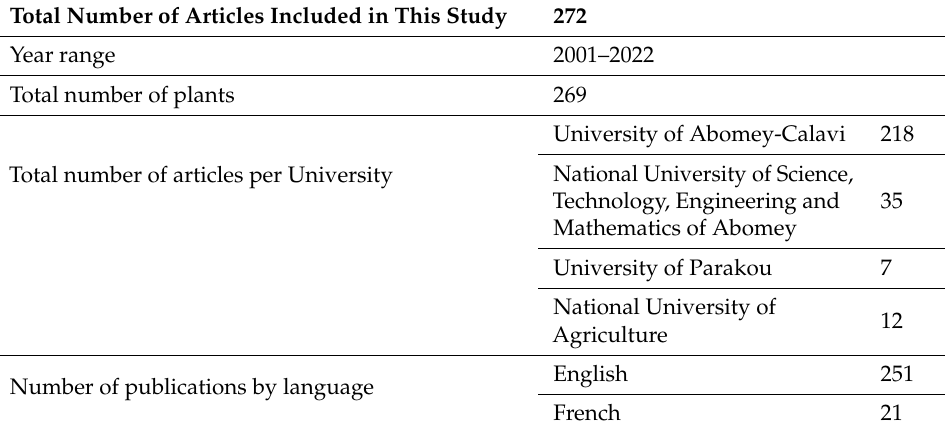
Table 4. Update on the scientific articles included in this study. Total Number of Articles Included in This